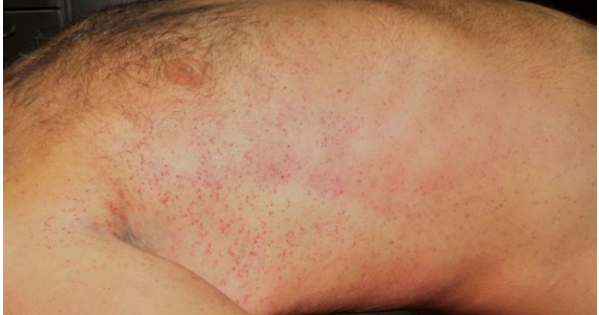
Figure 7. Petechiae located around the torso of patient 1 during post-mortem examination.